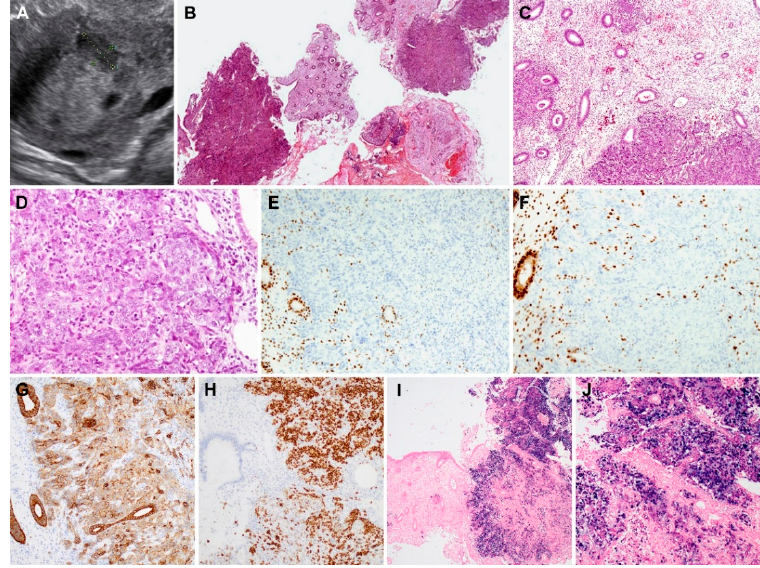
Figure 1. Histopathological findings, immunostaining results, and Epstein–Barr virus-encoded RNA in situ hybridization (EBER-ISH) results of metastatic non-keratinizing undi ff erentiated carcinoma of the nasopharynx (case 1). ( A ) Abdominopelvic ultrasonography reveals a hypoechoic endometrial mass. ( B ) On scanning view, several endometrial tissue fragments are totally or partially replaced by tumor tissues. ( C ) Low-power magnification shows variable-sized tumor cell clusters infiltrating the endometrial stroma. The glands are not involved; however, they are surrounded by tumor cells. ( D ) High-power magnification exhibits an admixture of tumor cells showing syncytial growth and polymorphic inflammatory cells. The tumor cells possess large pleomorphic nuclei with conspicuous nucleoli. ( E , F ) Tumor cells are negative for ( E ) estrogen receptor (ER) or ( F ) progesterone receptor (PR); in contrast, these proteins are uniformly and strongly expressed in the nuclei of endometrial glandular epithelium and stromal cells. ( G ) Intensity of CK7 immunoreactivity is strong and moderate in the endometrial glandular epithelium and tumor cells, respectively. ( H ) Tumor cells display